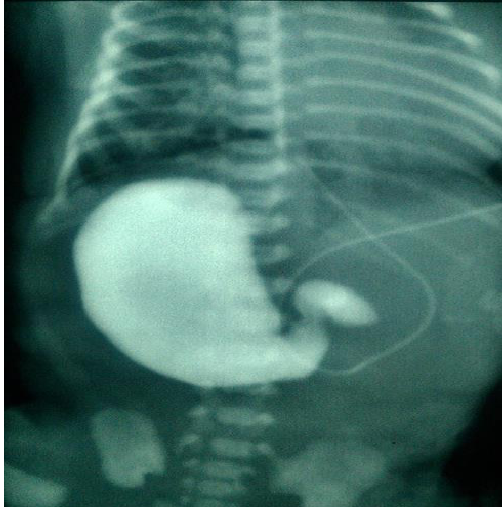
Figure 1: Contrast study showing right sided stomach and duodenal